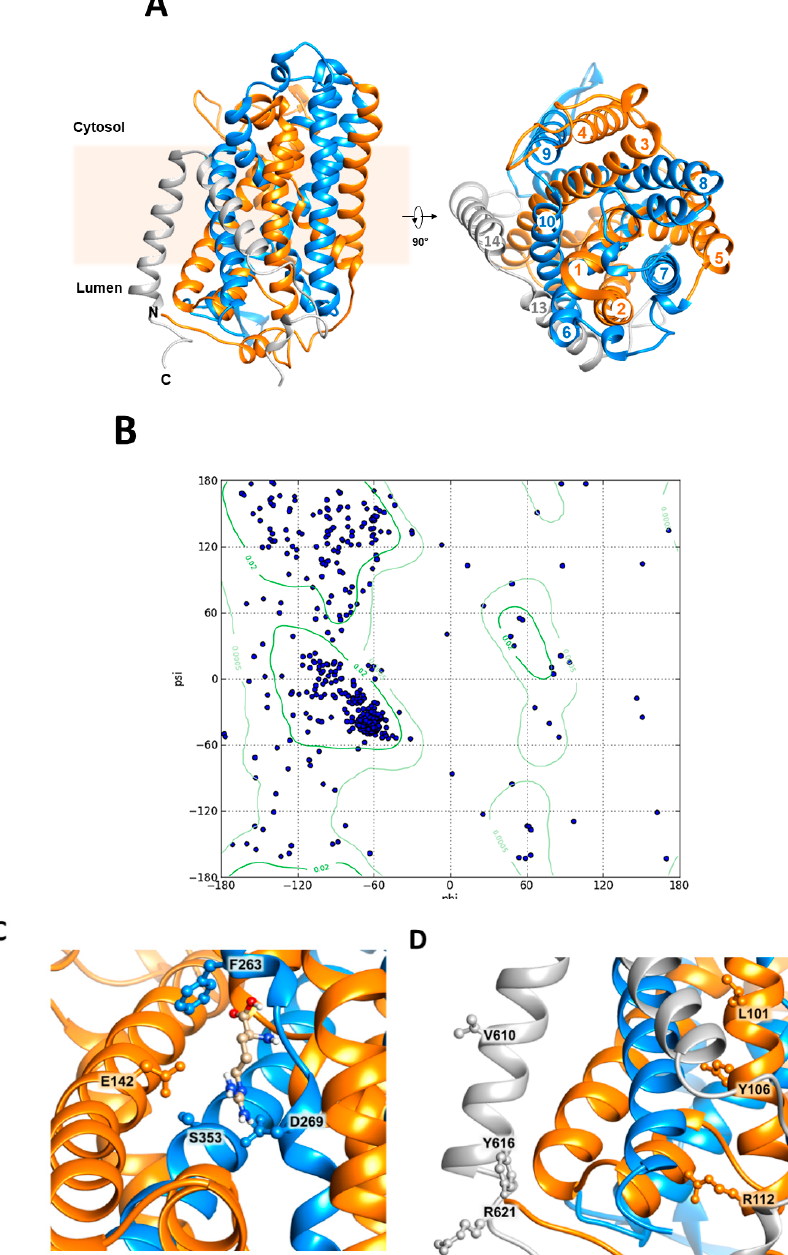
Figure 12. Homology structural model of Sl CAT2. The three-dimensional model is built, as described in Section 4.7, using the Gk ApcT atomic coordinates (5OQT) as a template. The α -helices are colored in orange or in blue to identify the pseudo two-fold symmetry axis of LeuT-fold. The α -helices which are not part of LeuT fold are colored in gray. The model is designed using the Chimera 1.13.1 software. ( A ) The protein is inserted in the membrane with the N- and C-termini in the luminal space (left-front view); on the right, the model is rotated by 90 °C showing the top view and α -helices are numbered. ( B ) Ramachandran plot of the model in A with residues in favored (smaller gate) and allowed (larger gate) regions. The residues are depicted as blue circles. ( C ) Molecular docking of arginine in the putative binding site of Sl CAT2; residues putatively responsible for arginine binding and gating (S353, D269, and F263) together with the residue putatively responsible for proton coordination (E142) are indicated in the ball and stick representation. ( D ) Residues of CRAC motifs responsible for cholesterol binding are highlighted in TM 2 (orange α -helix) and TM 14 (gray α -helix) in the ball and stick representation; numbering of α -helices corresponds to that of Figure